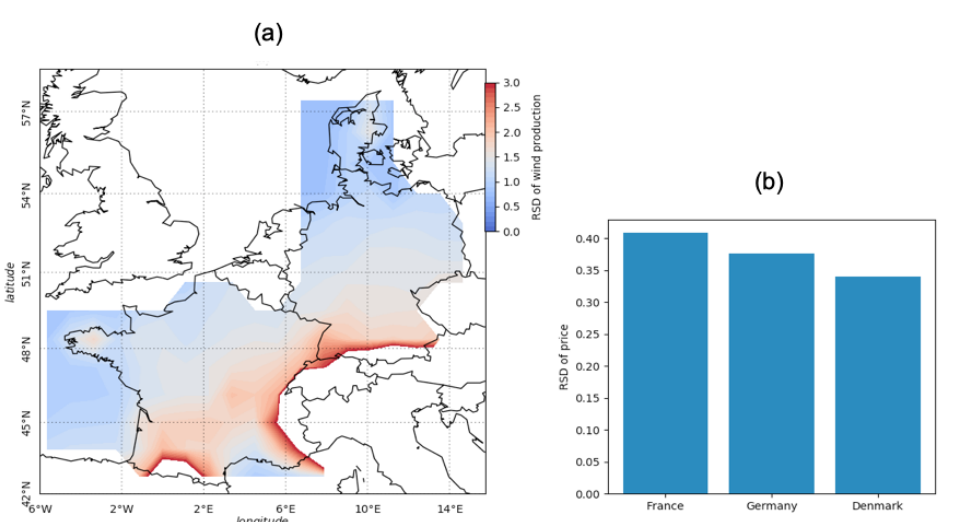
Figure 2. Relative standard deviation (RSD) of the capacity factor ( a ) and prices ( b ).